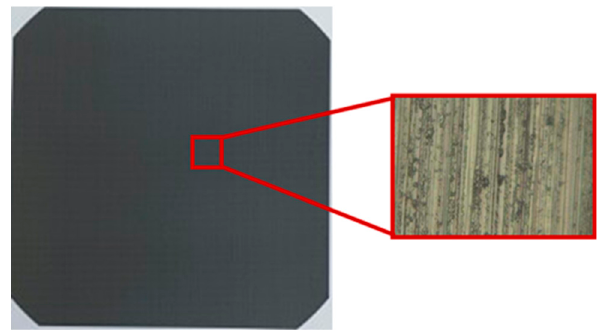
Figure 4. Wafer surface measured using an optical microscope.